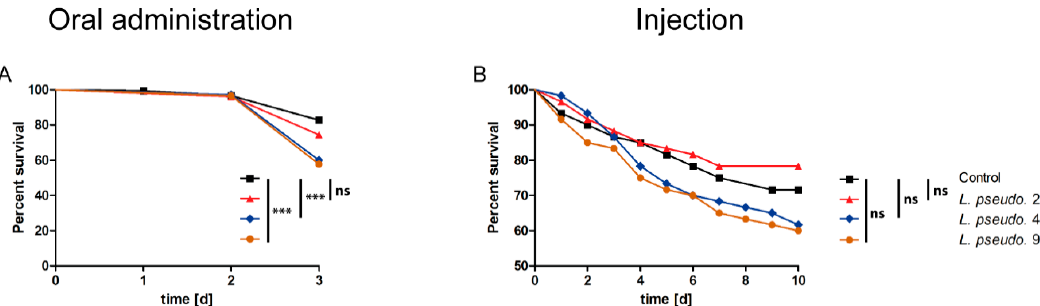
Figure 6. Survival curves for the oral and septic administration of Leuconostoc pseudomesenteroides extracts to Acyrthosiphon pisum nymphs (5 days old). ( A ) Oral administration of extracts prepared after bacterial cultivation for 24, 48 or 96 h, or an extract of sterile culture medium as a control, reconstituted in the advanced AP3 medium. Each treatment group represents n = 180 aphids (720 in total). ( B ) Injection of the same extracts reconstituted in PBS. Each treatment group represents n = 60 aphids (240 in total). Survival data were tested for significance using the logrank test. Each graph represents a composition of three biological replicates. Statistical significance is indicated as follows: p ≤ 0.0009 ***; p ≤ 0.009 **; p ≤ 0.09 *; ns, not significant.